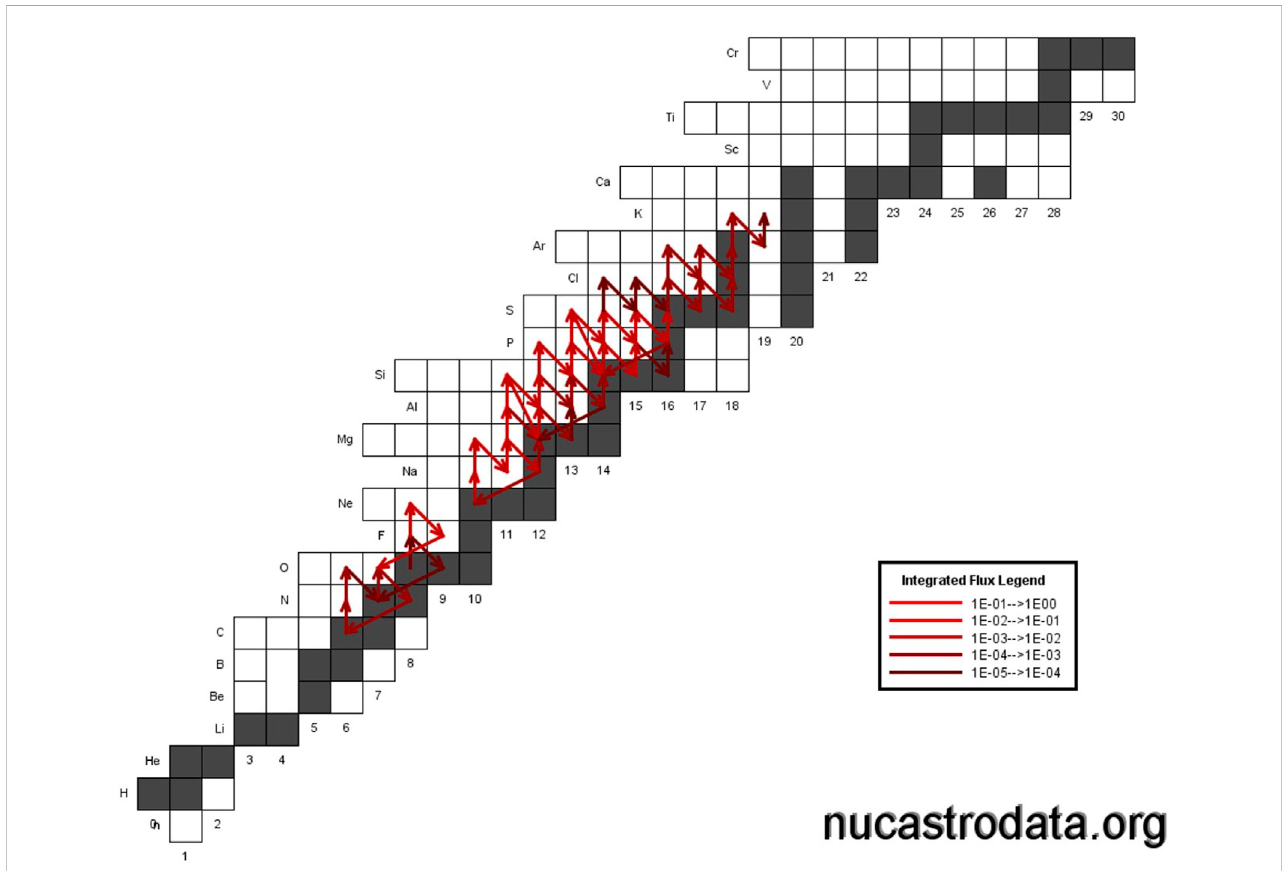
FIGURE 2 Asnapshotofthenuclearreaction fl owofanenergeticnovaexplosion.Thecolorofthearrowsindicatesthefractionofthetotalintegrated fl ow(i.e., fl ux) that proceeds through a given reaction. Pronounced cycling can occur with individual cycles closed by ( p , α )